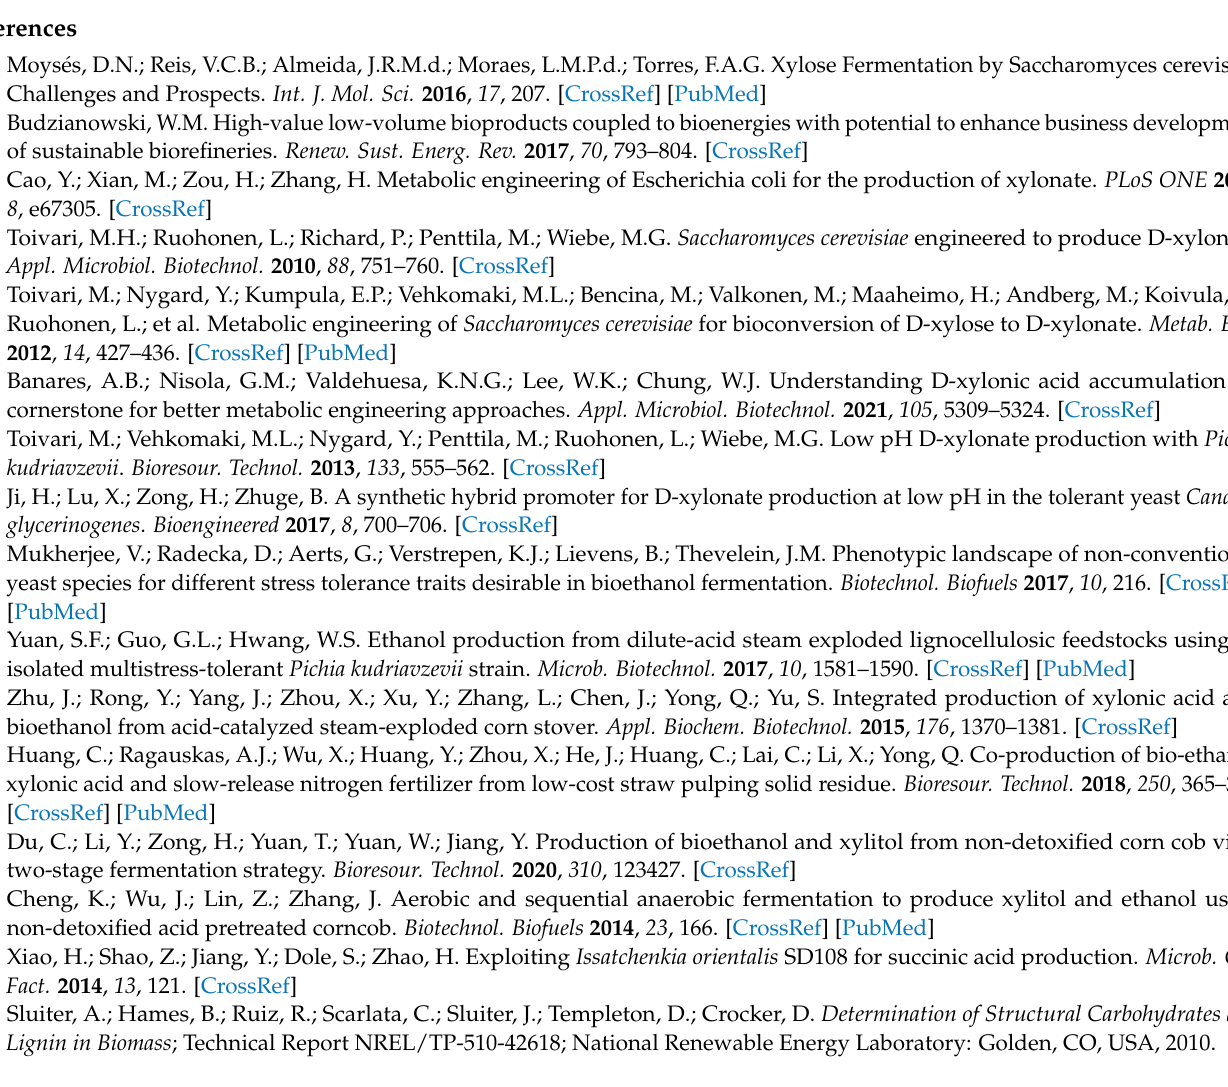
Supplementary Materials: The following are available online at https://www.mdpi.com/article/ the URA3 pop-out system, Table S1: Sequence of NAD+ -dependent xylose dehydrogenase gene xylB , Table S2: Primers used in this study, Table S3: Ethanol production of P. kudriavzevii N-X in YP medium containing different concentrations of D -glucose by shaking flasks at 100 rpm and 37 ◦ C, Table S4: Ethanol production of P. kudriavzevii N-X in YP medium containing 150 g/L D -glucose glucose by shaking flasks at 100 rpm and different